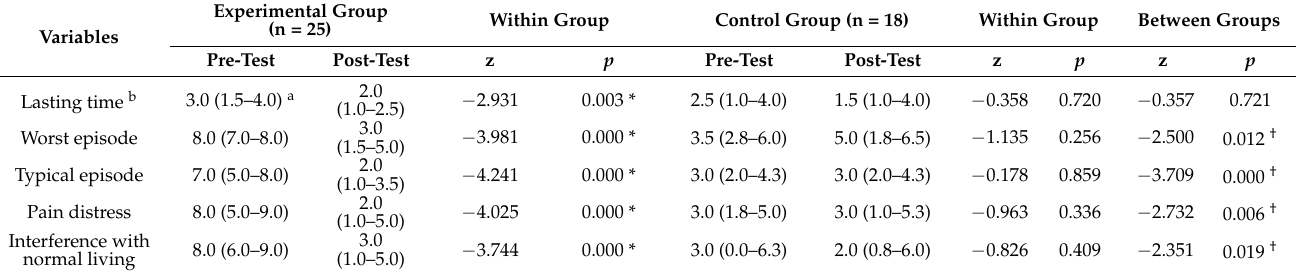
Table 5. Pain characteristics, pain distress, and interference with normal